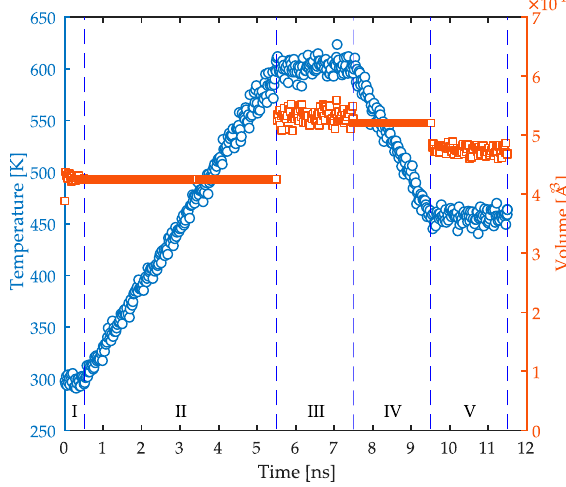
Figure 1. The temperature ( circles ) and volume ( squares ) of the system during the relaxation process as a function of time. Each stage of the process is numbered and separated with vertical dashed lines.